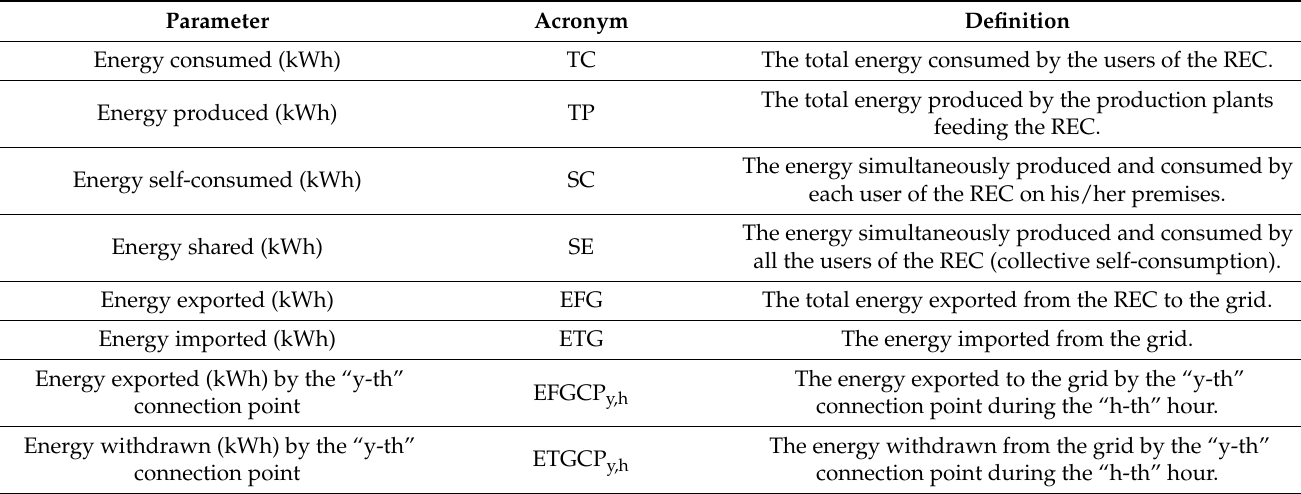
Table 2. Parameters of interest for the REC performance